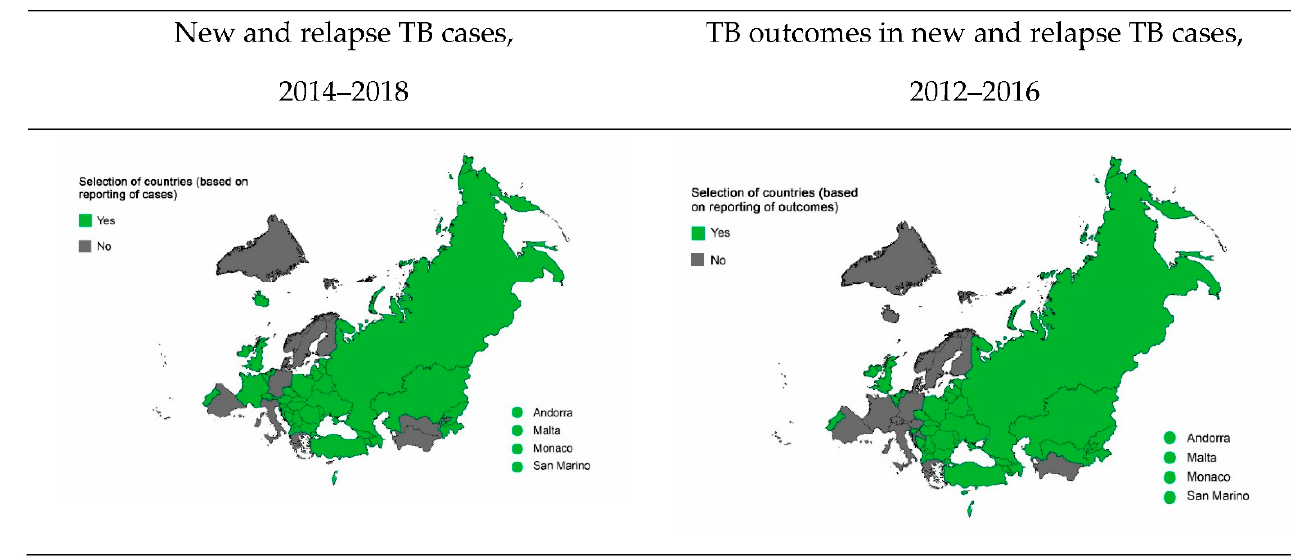
Figure 1. Countries/states selected for case analysis based on the availability of TB reporting forms. TB: tuberculosis; WHO: World Health Organization.